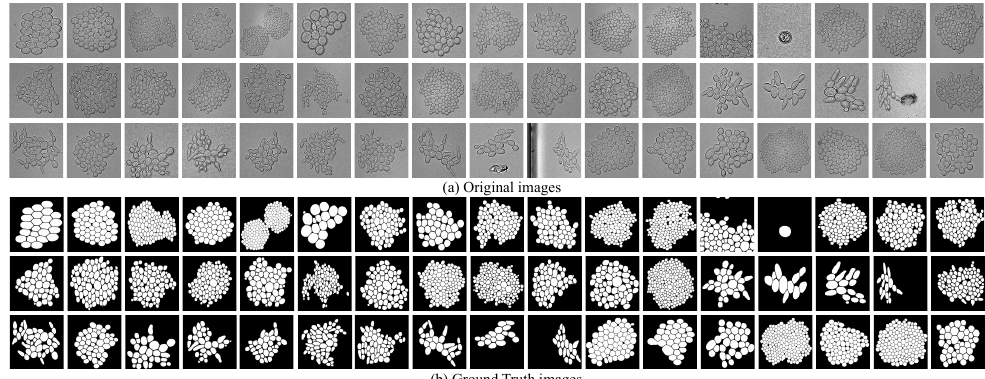
Figure 4. The images in yeast cell dataset. ( a ) The original yeast image and ( b ) the corresponding ground truth